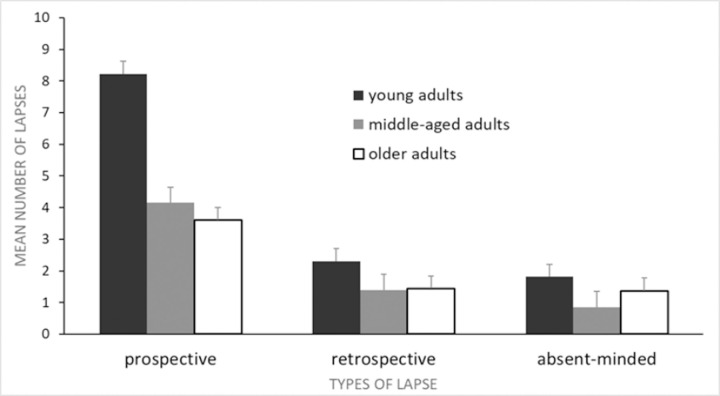
Mean number of memory lapses as a function of type of lapse (prospective, retrospective, absent-minded) and group (young adults, middle-aged adults, older adults).Error bars represent 1 SE of the mean.